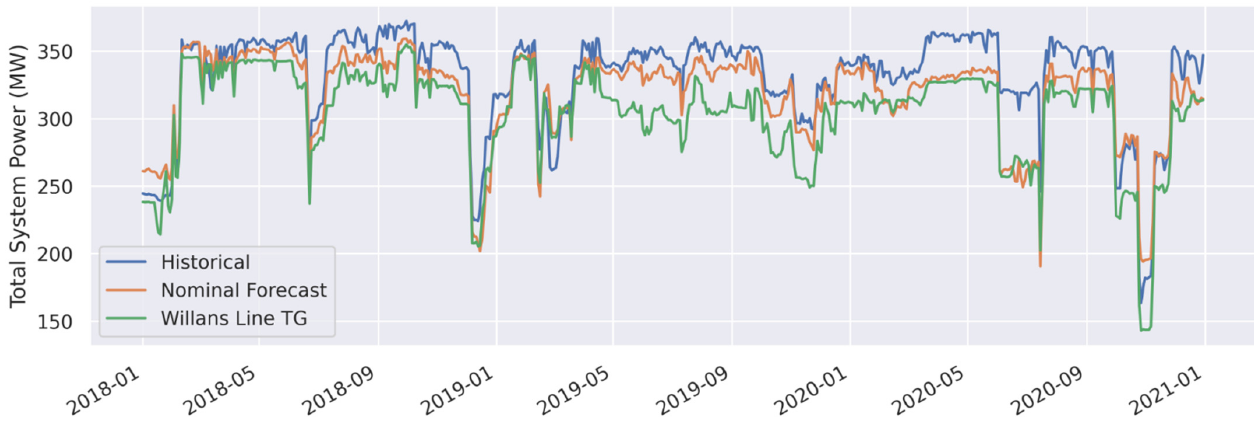
Figure 5. Intermediate pressure ( left ) and low pressure ( right ) separated steam flow to the Te Mihi power station, comparing historically measured data versus the nominal forecast model (including the neural network flash plant model) and the theoretical flash plant forecast (using steam quality at separation pressure as separation efficiency).